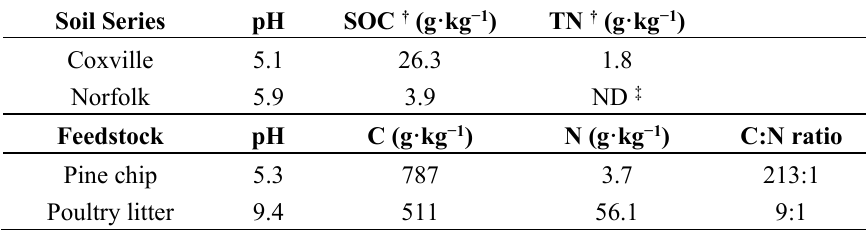
Table 5. Chemical properties of soil and biochar utilized in